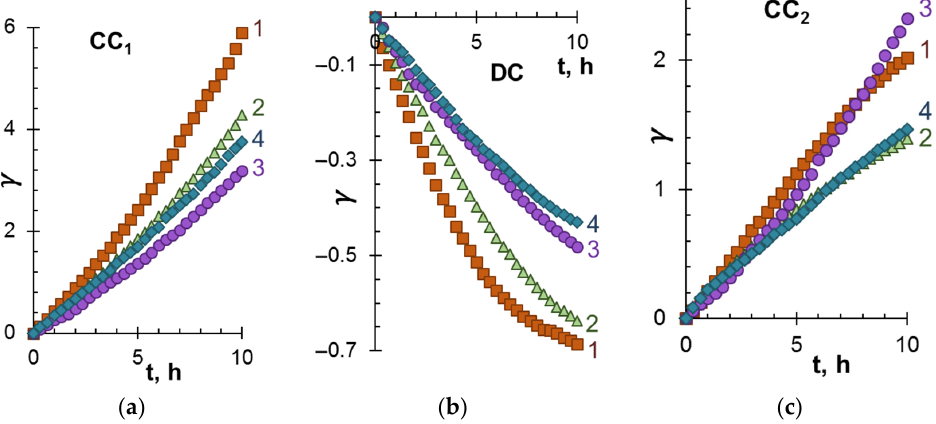
Figure 3. The degree of demineralization and concentration in the CC1 ( a ), DC ( b ) and CC2 ( c ) tracts vs. duration of electrodialysis of model solutions. The numbers of the curves correspond to the designations of the solutions in Table 2.